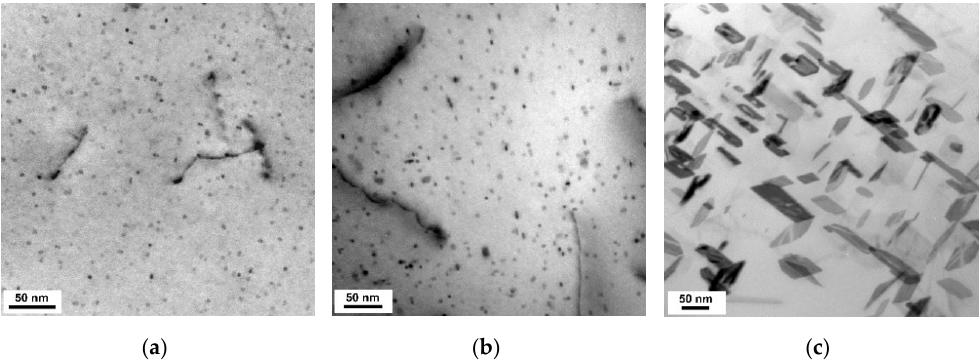
Figure 4. Bright field TEM micrographs of diecast AlSi9Cu3(Fe) alloy (Alloy 1) showing precipitation in the α -Al matrix: ( a ) before thermal exposure; after 30 min at ( b ) 150 °C and ( c ) 200 °C.